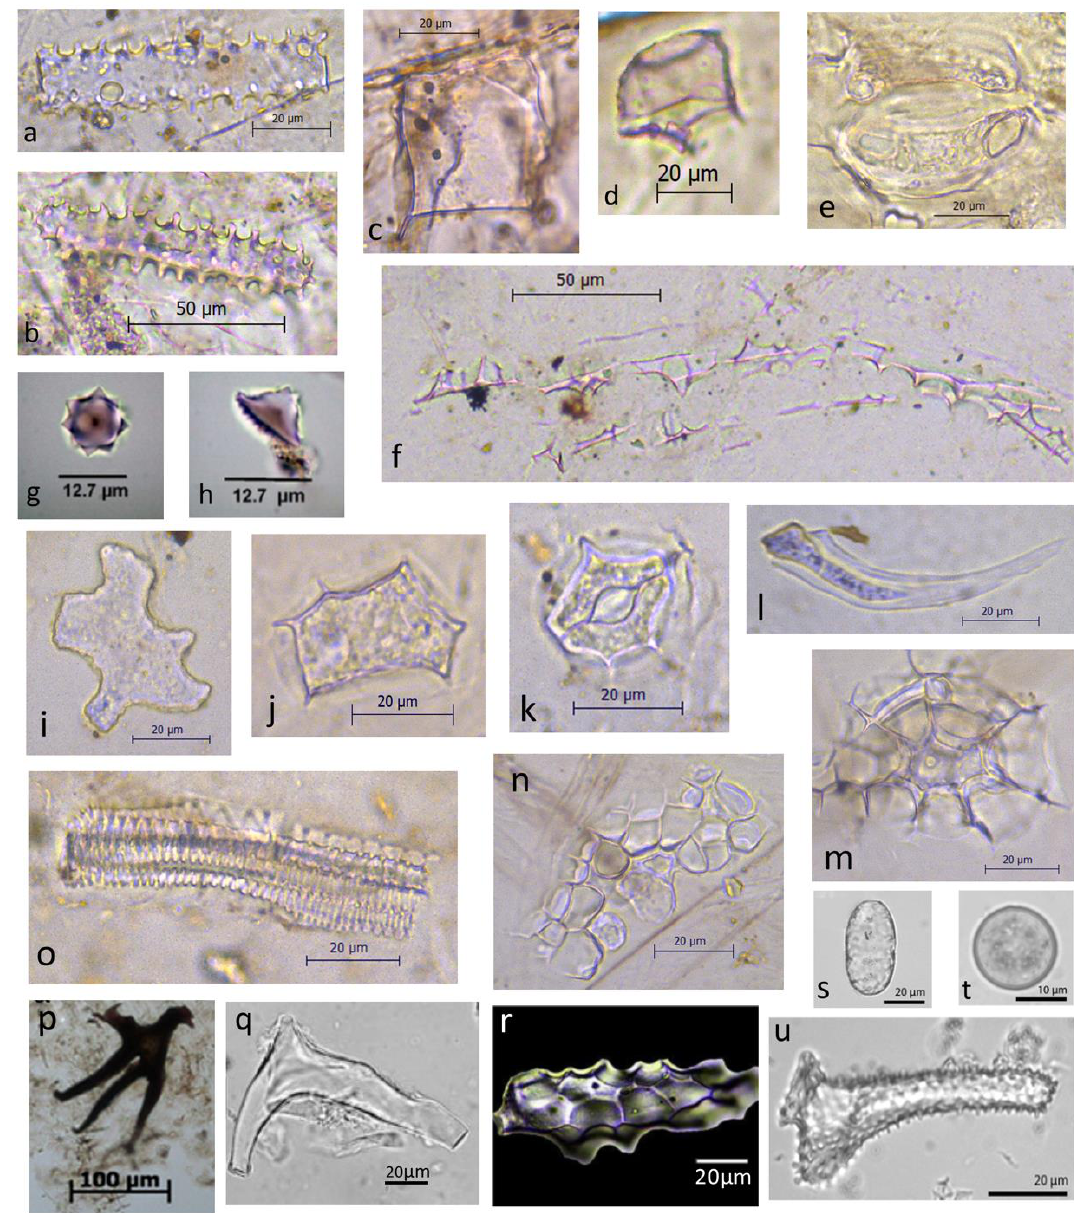
Figure 1. Phytolith morphotypes in woody plants: ( a ) Epidermal phytolith, Picea asperata (N); ( b ) Hypodermis, Picea asperata (N); ( c ) Block, Pinus bungeana (N); ( d ) Transfusion tracheid, Abies georgei (N); ( e ) Stoma, Abies georgei (N); ( f ) Cuneiform, Larix principis-rupprechtii (N); ( g ) Spheroid echinate, Ammandra decasperma (L); ( h ) Conical. Bactris sphaerocarpa (L); ( i ) Jigsaw, Berberis thunbergii (L); ( j ) Polygonal, Quercus mongolica (L); ( k ) Stomata, Betula platyphylla (L); ( l ) Hair, Quercus mongolica (L); ( m ) Hair base, Acer pilosum var. stenolobum (L); ( n ) Honeycomb assemblage, Acer pilosum var. stenolobum (L); ( o ) Tracheary, Berberis thunbergii (L); ( p ) Asterosclereid, Pseudotsuga menziesii (N); ( q ) Y-shaped Sclereid, Erythroxylum mucronatum (L); ( r ) Facetate, Pittosporum truncatum (L); ( s ) Ellipsoid, Lannea acida (W); ( t ) Spheroid psilate, Malacantha alnifolia (W); ( u ) Sclereid pitted, Klainedoxa gabonensis (B); (B) = Bark, (L) = Leaf, (N) = needle, (W) = Wood. ( g , h ) reprinted with permission from Morcote-Ríos et al., 2016, Oxford University Press. ( r ) reprinted with permission from Ge et al., 2020, CC BY license. ( s – u ) reprinted with permission from Collura, L.V. and Neumann, K., 2017, Elsevier. ( p ) reprinted with permission from McCune, J.L. and Pellatt, M.G., 2013, Elsevier. ( q ) reprinted with permission from Watling, J. and Iriarte, J., 2013, Elsevier.